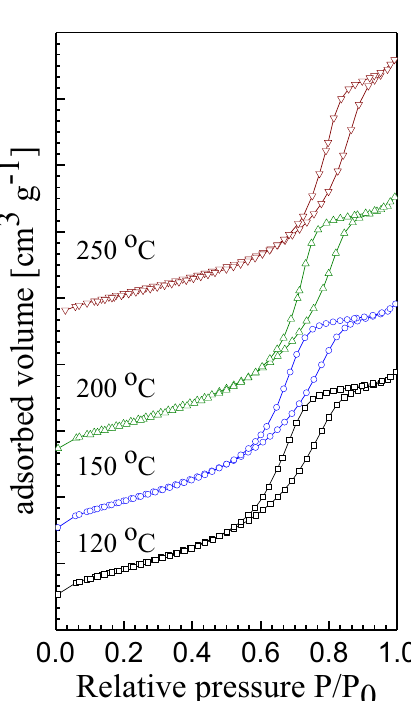
Fig. 2 N 2 adsorption–desorption spectra of mesoporous TiO 2 samples